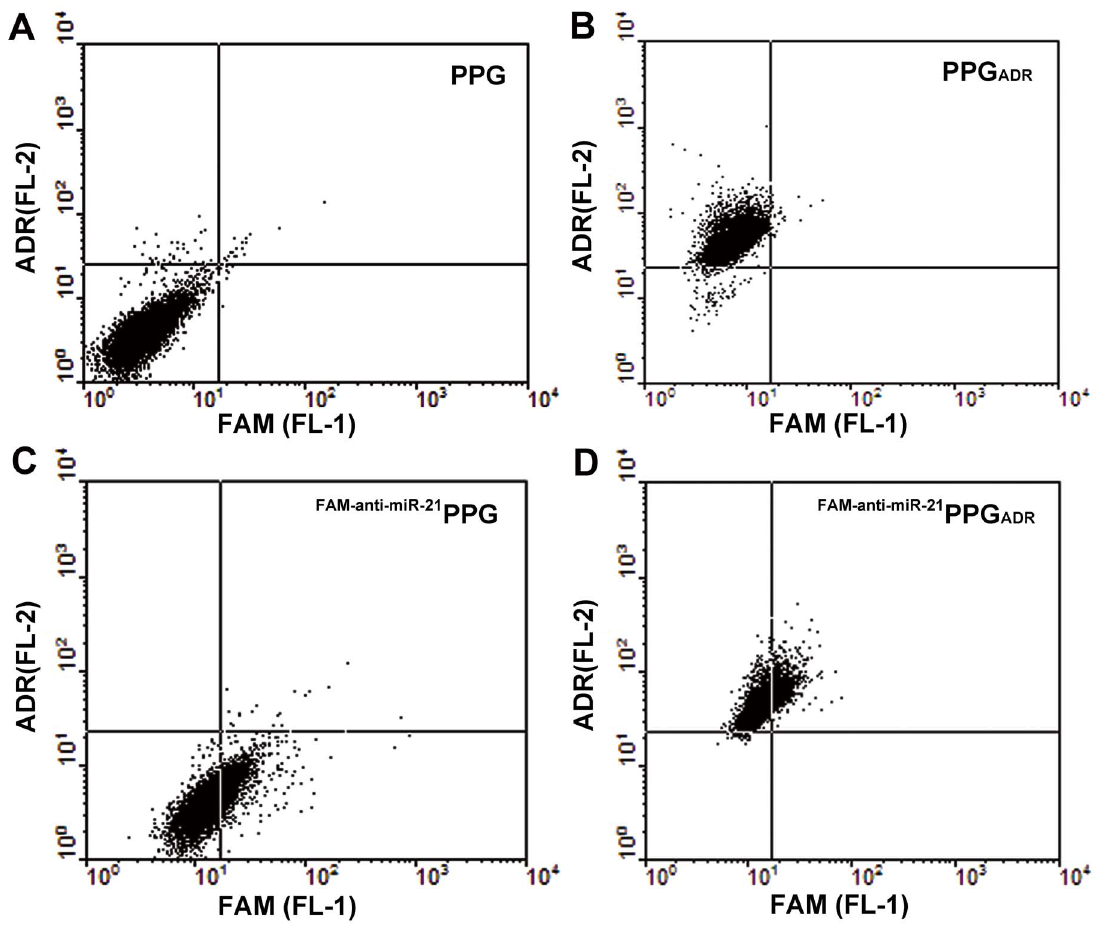
Figure 4. Characterization by flow cytometry of PPG co-delivering anti-miR-21 and ADR. MCF-7/ADR cells were incubated with PPG ADR , FAM-anti-miR-21 PPG, FAM-anti-miR-21 PPG ADR at 37 u C for 4 h and harvested for flow cytometry analysis. Cells treated with blank PPG served as a control.